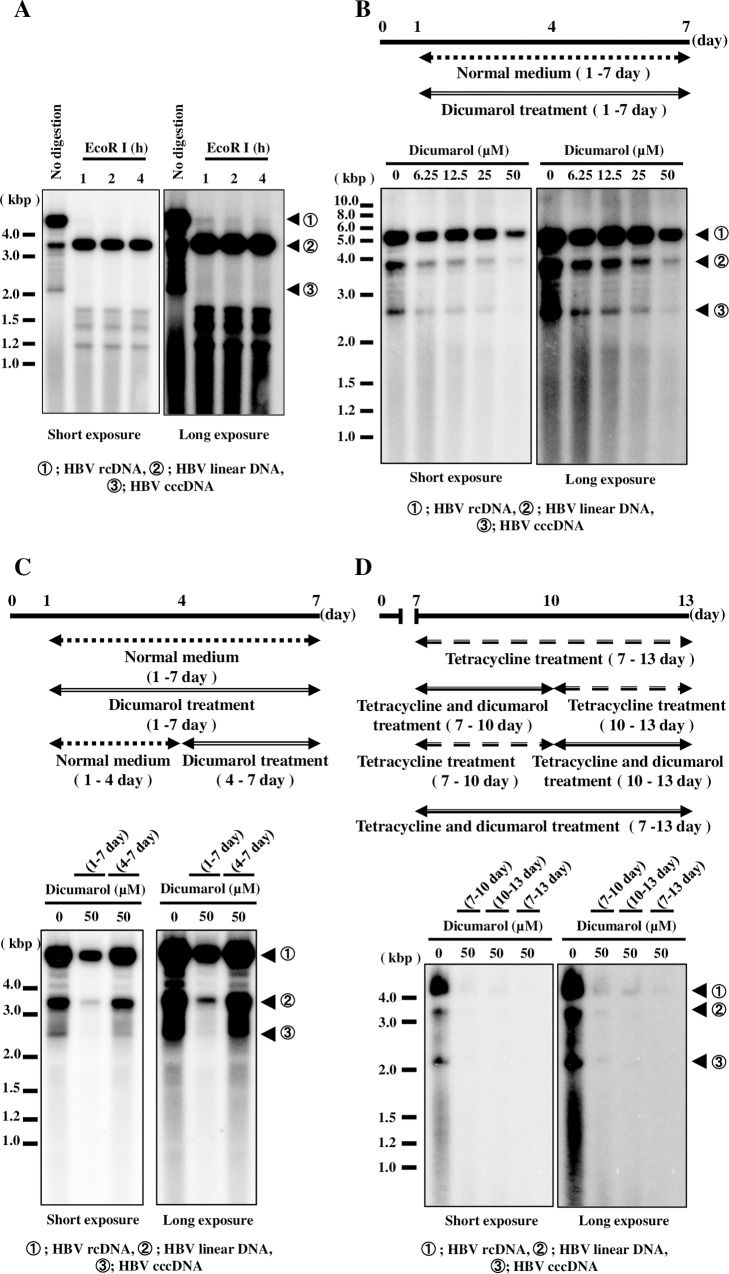
Dicumarol inhibits HBV cccDNA.HBV expression was induced in Hep38.7 cells by depleting tetracycline in the common DMEM including G418 medium for 7 days. (A) HIRT DNA was extracted and analyzed by Southern blotting. The DNA was undigested or digested with EcoRI for 1, 2, or 3 h. The positions of rcDNA, linear DNA, and cccDNA are indicated. (B) Cells were treated with increasing amounts of dicumarol as indicated. HIRT DNA (undigested) was subjected to Southern blotting. (C) Cells were treated with dicumarol as shown. HIRT DNA was extracted at 7 day and subjected to Southern blotting. (D) At first, Hep38.7 cells were cultured in common DMEM including G418 medium without tetracycline at 0–7 day. At 7day, cell medium was replaced fresh DMEM including tetracycline in the absence (dicumarol 0 μM, 10–13 day dicumarol 50 μM) or presence (7–10 day dicumarol 50 μM, 7–13 day dicumarol 50 μM) of dicumarol. At 10 day, cell medium was replaced fresh DMEM including tetracycline in the absence (dicumarol 0 μM, 7–10 day dicumarol 50 μM) or presence (10–13 day dicumarol 50 μM, 7–13 day dicumarol 50 μM) of dicumarol. Finally, HIRT DNA was collected at 13 day. Data are from one representative of at least two independent experiments.